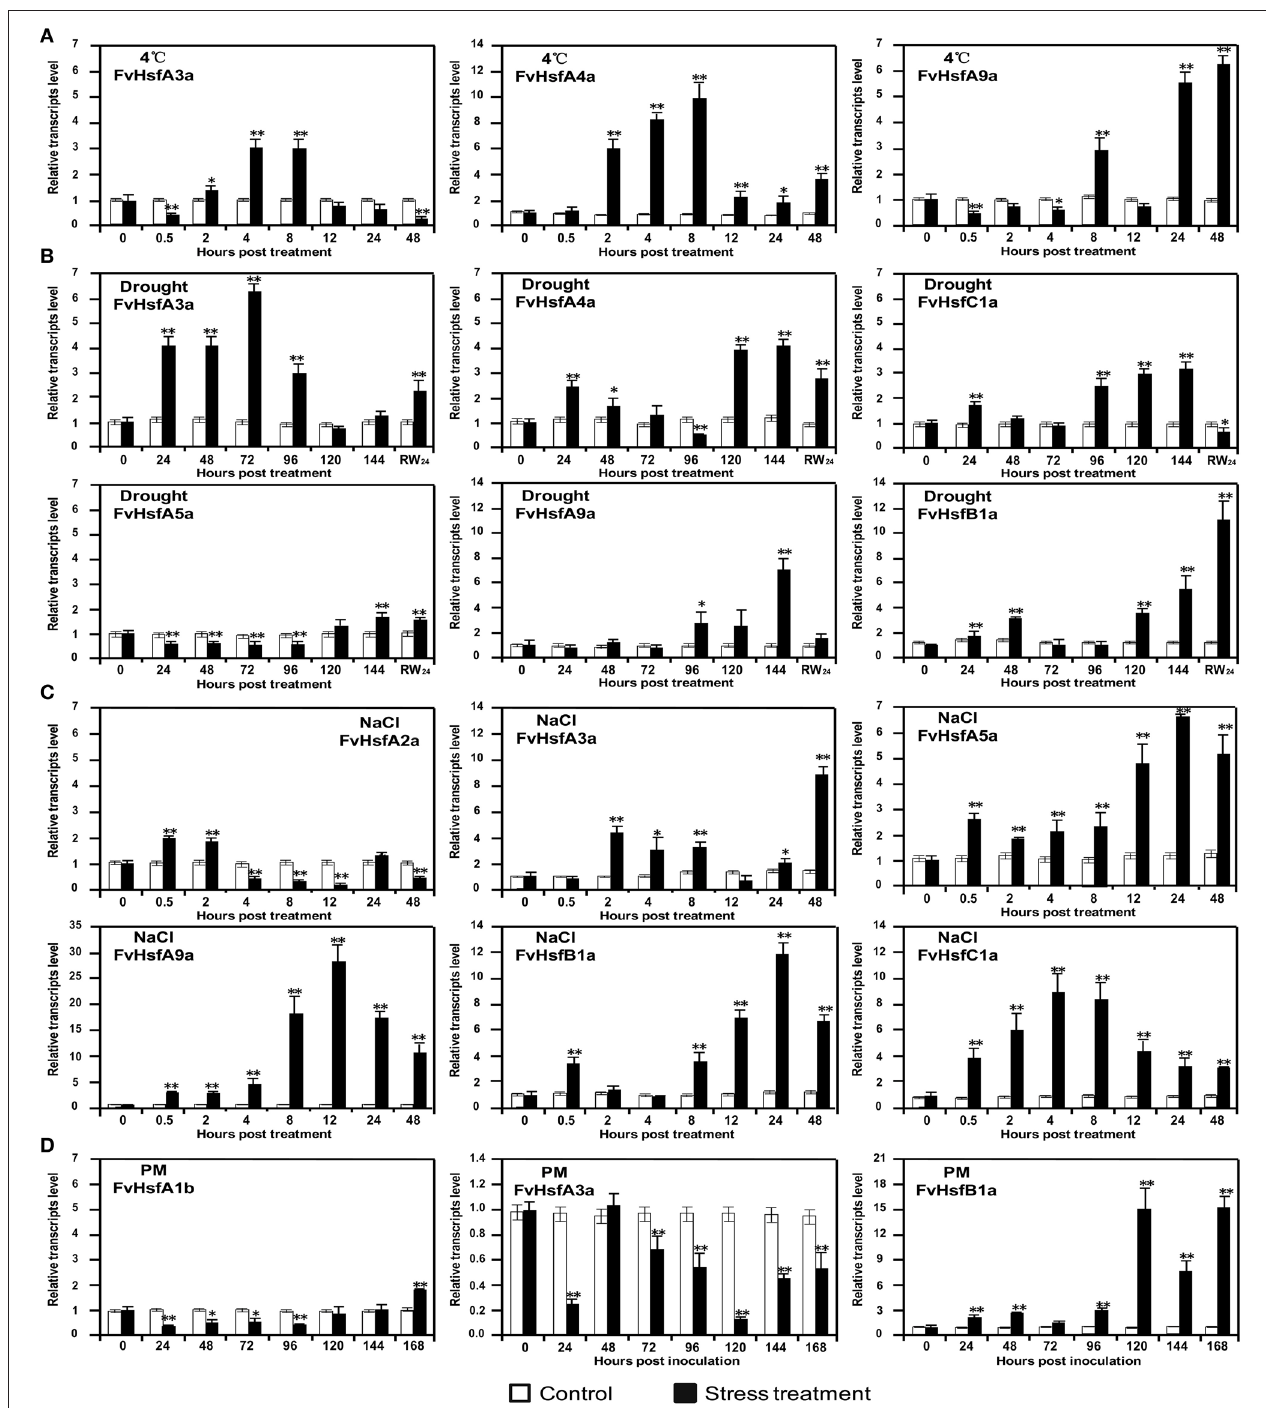
FIGURE 7 | The expression of Hsf genes in the diploid woodland strawberry ( F. vesca ) in response to 4 ◦ C, drought, salt, and Podosphaera aphanis (PM) treatments. The expression levels of several representative FvHsf genes showed unusual patterns in response to 4 ◦ C (A) , drought (B) , salt (C) , and PM (D)